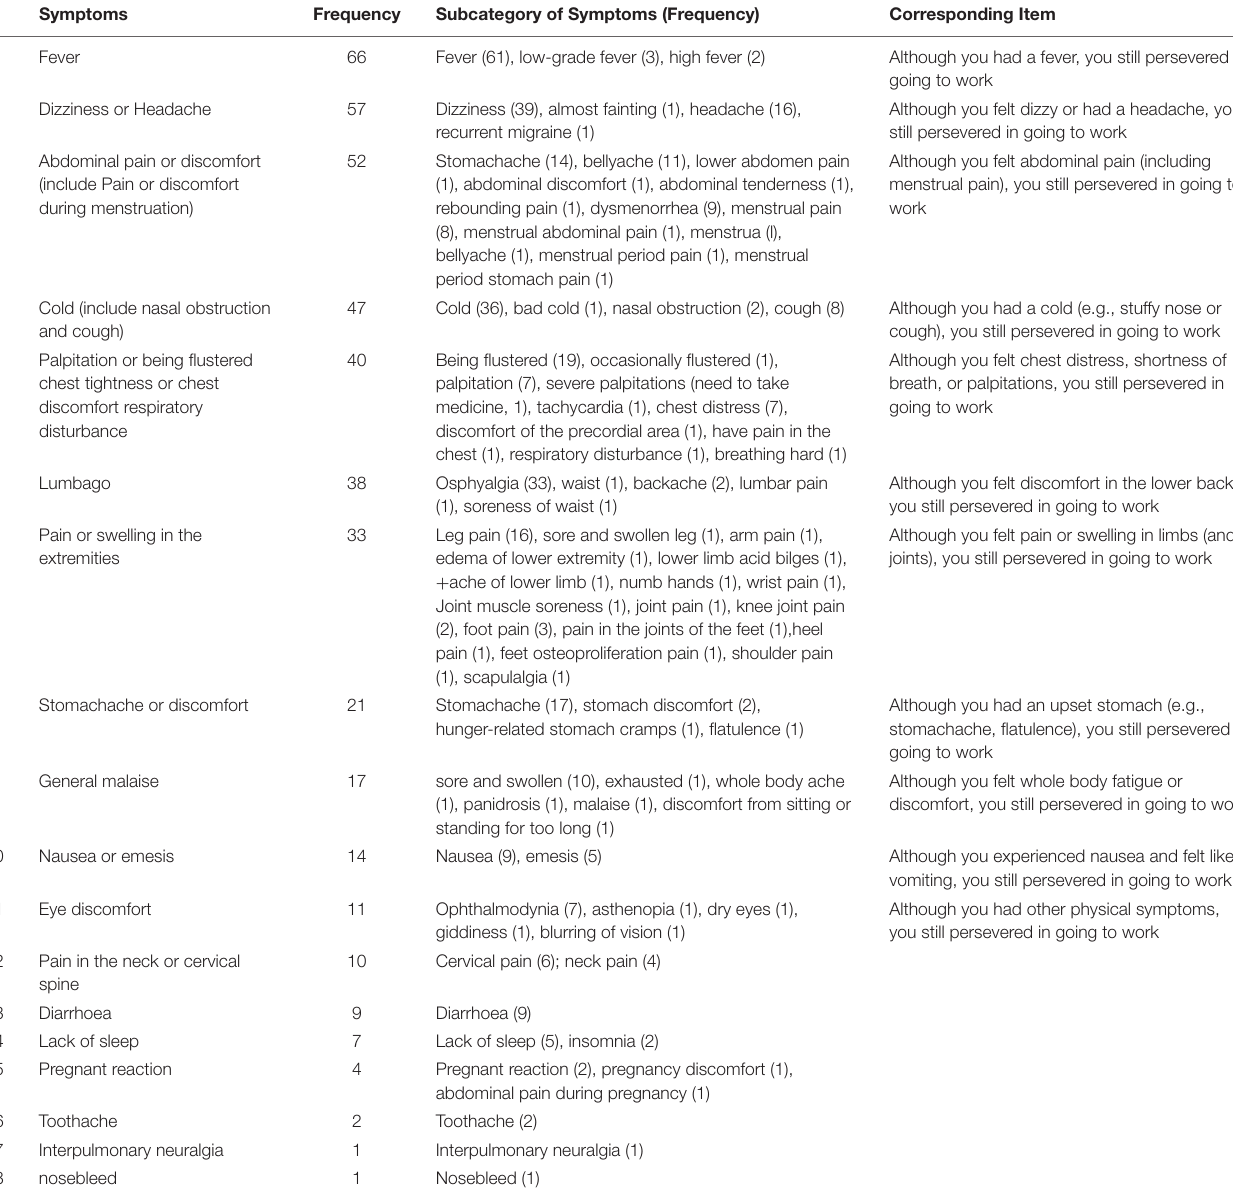
TABLE 4 | The core symptoms when presenteeism occurred and corresponding scale